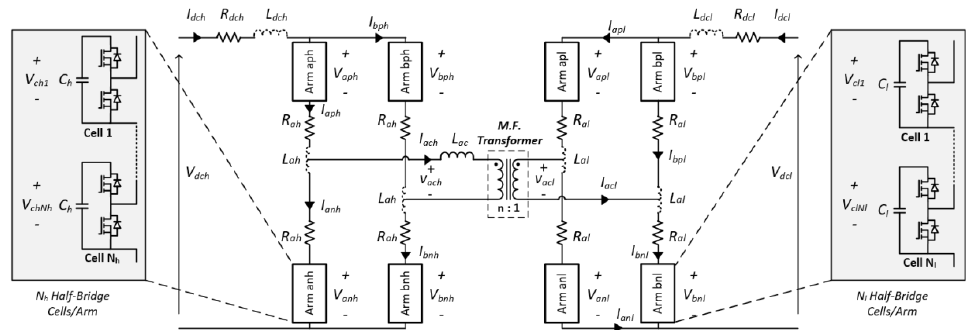
Figure 21. MMC-based topology operating as an isolated DC/DC converter